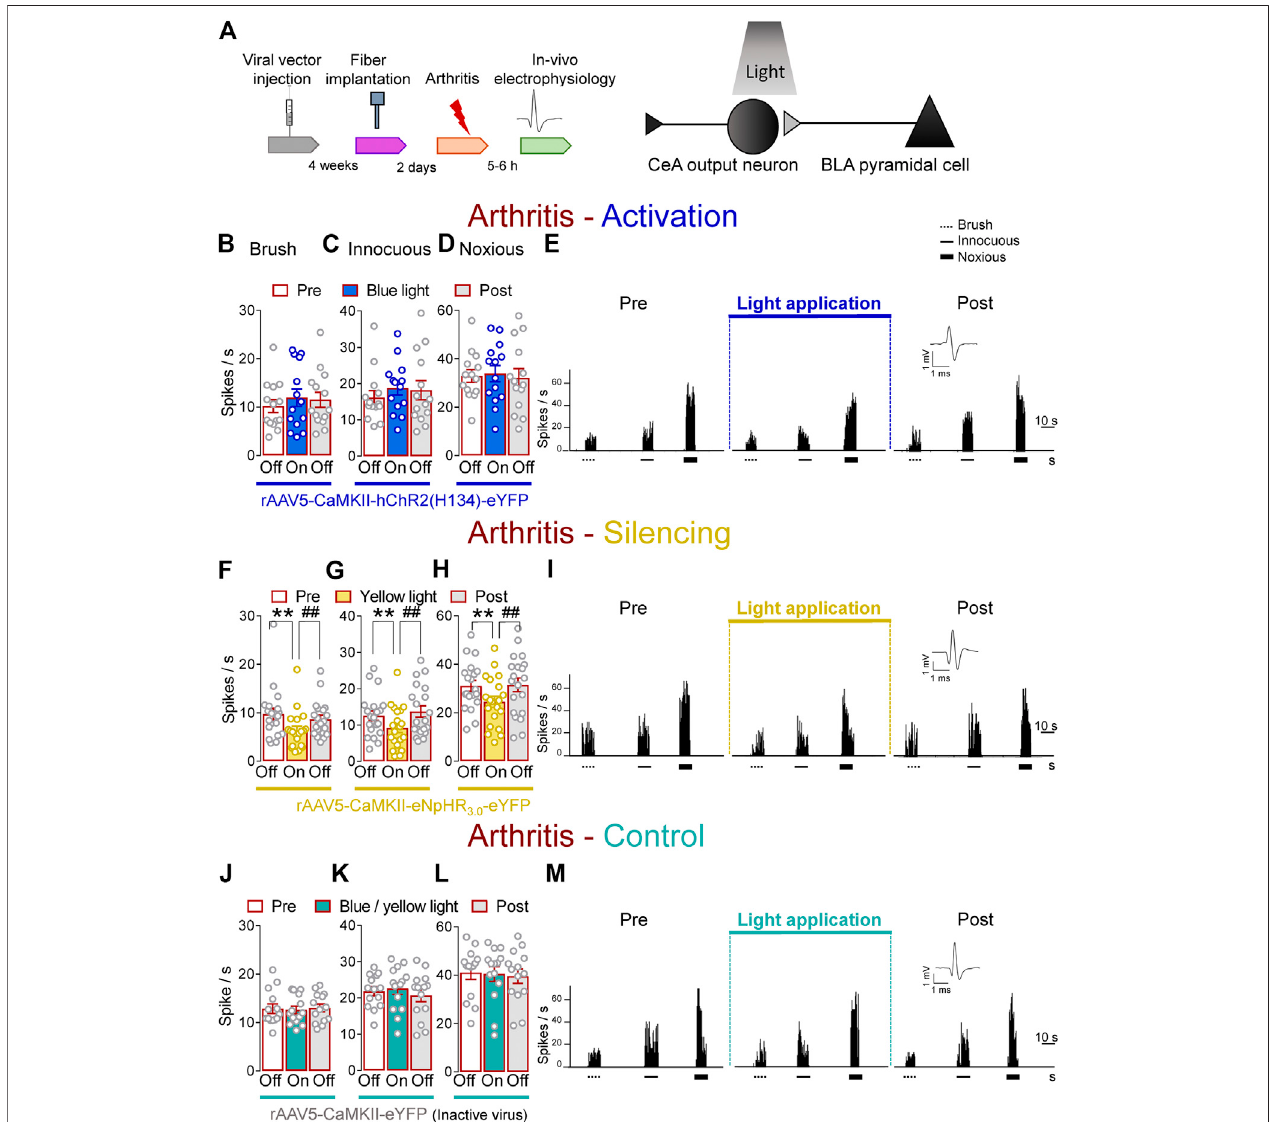
FIGURE 3 | Optogenetic silencing of BLA axon terminals in the CeA in the arthritis pain model reduces the increased activity of spinal cord neurons. (A) Experimental design. Responses of WDR neurons ( n (cid:1) 14) to brushing the skin (B) and innocuous (C) and noxious (D) compression of the left knee joint were not signi fi cantly affected by the optical activation of ChR2 expressed on BLA – CeA terminals with blue (473 nm) light ( “ On ” , 20 Hz, 5 mW, 5 – 10 min) compared to no light ( “ Off ” )valuesinarthriticrats. (E) Peristimulustimehistograms(500 msbinsize)showrecordingsofasingleWDRneuronbefore,duringandafterblue(473 nm)light application(20 Hz,5 mW,5 – 10 min)inanarthriticrat.Barhistogramsshowmeans ± SEM. (F – H) Samedisplayas (B – D) butforBLA – CeAterminalinhibitionwithyellow (590 nm)light( “ On ” )toactivateeNpHR 3.0 ( n (cid:1) 8). (I) Samedisplayas (E) butforBLA – CeAterminalsilencing( n (cid:1) 20).**, ## p < 0.01,repeatedmeasuresone – wayANOVA withBonferroni posthoc tests. (J – L) Same display as (B – D) but inYFP – expressing control ratswithblue(473 nm, n (cid:1) 7)or yellow (590 nm, n (cid:1) 7) light( “ On ” ) application ( n (cid:1) 14). (M) Same display as (E) but in a YFP – expressing control rat.